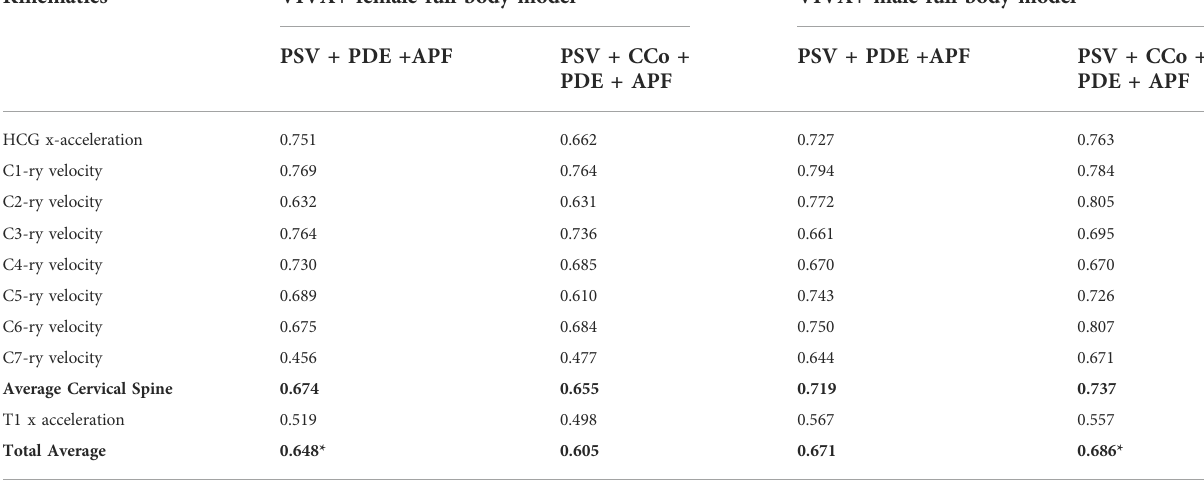
TABLE 7 CORA score of female and male full-body model for whiplash injury assessment simulation.